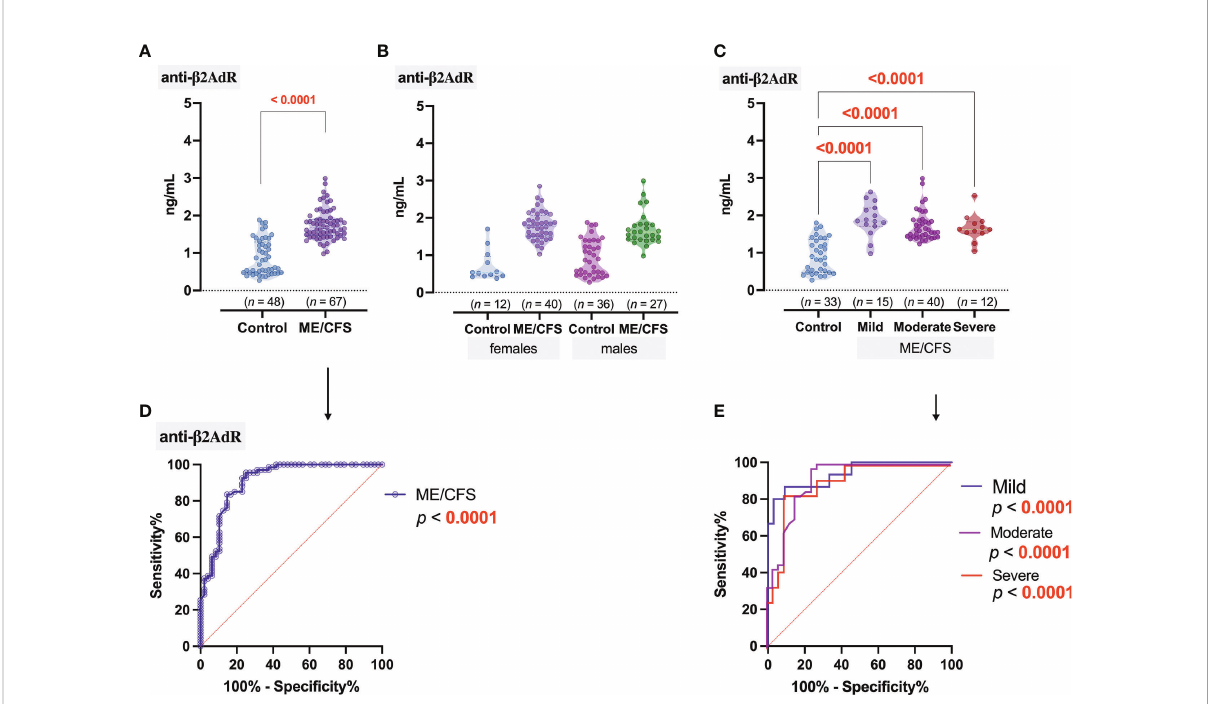
FIGURE 4 Concentration of antibodies to b 2 adrenergic receptors (anti- b 2AdR): (A) Healthy control (donors) and ME/CFS patients. (B) Regarding women and men of both groups. (C) Regarding ME/CFS severity; numbers above graphs show p -value, determined by Mann – Whitney test (A) or Kruskal – Wallis test with respective post-test (B, C) . (D, E) ROC analysis showing the potential of anti- b 2AdR as a discriminating marker for